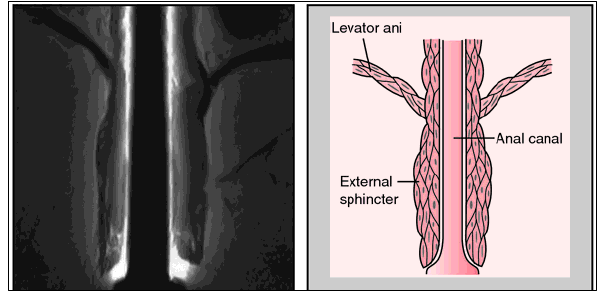
Figure 1: Diagrammatic representation of levator ani. Gender variations in the type of malformations must also be clearly defined before primary workup and management plan is drawn.